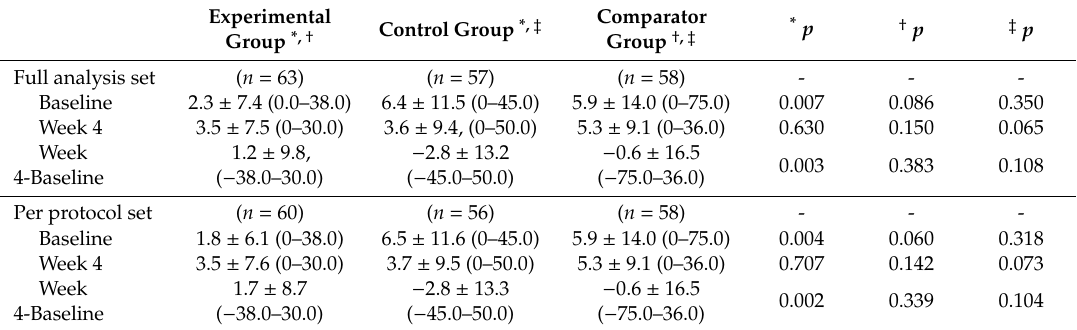
Table 4. Changes in pain visual analogue score (VAS) scores between baseline and 4 weeks after